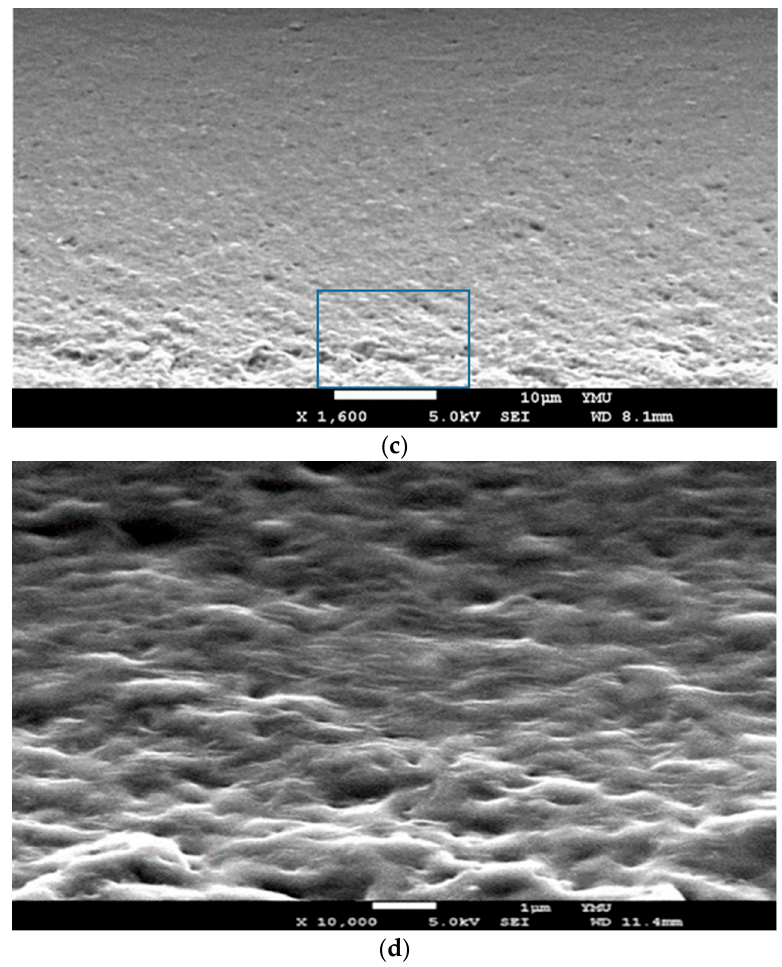
Figure 3. ( a ) SEM micrograph for the surfaces of GDES films (×4k), ( b ) SEM micrograph for the surfaces of GDES films after they scavenged H 2 O 2 (×4k). ( c ) The SEM of cross-section of the GDES films after they were used to scavenge H 2 O 2 are shown. ( d ) Shows high magnitude of micrograph at the bottom area of center region in Figure 3c.